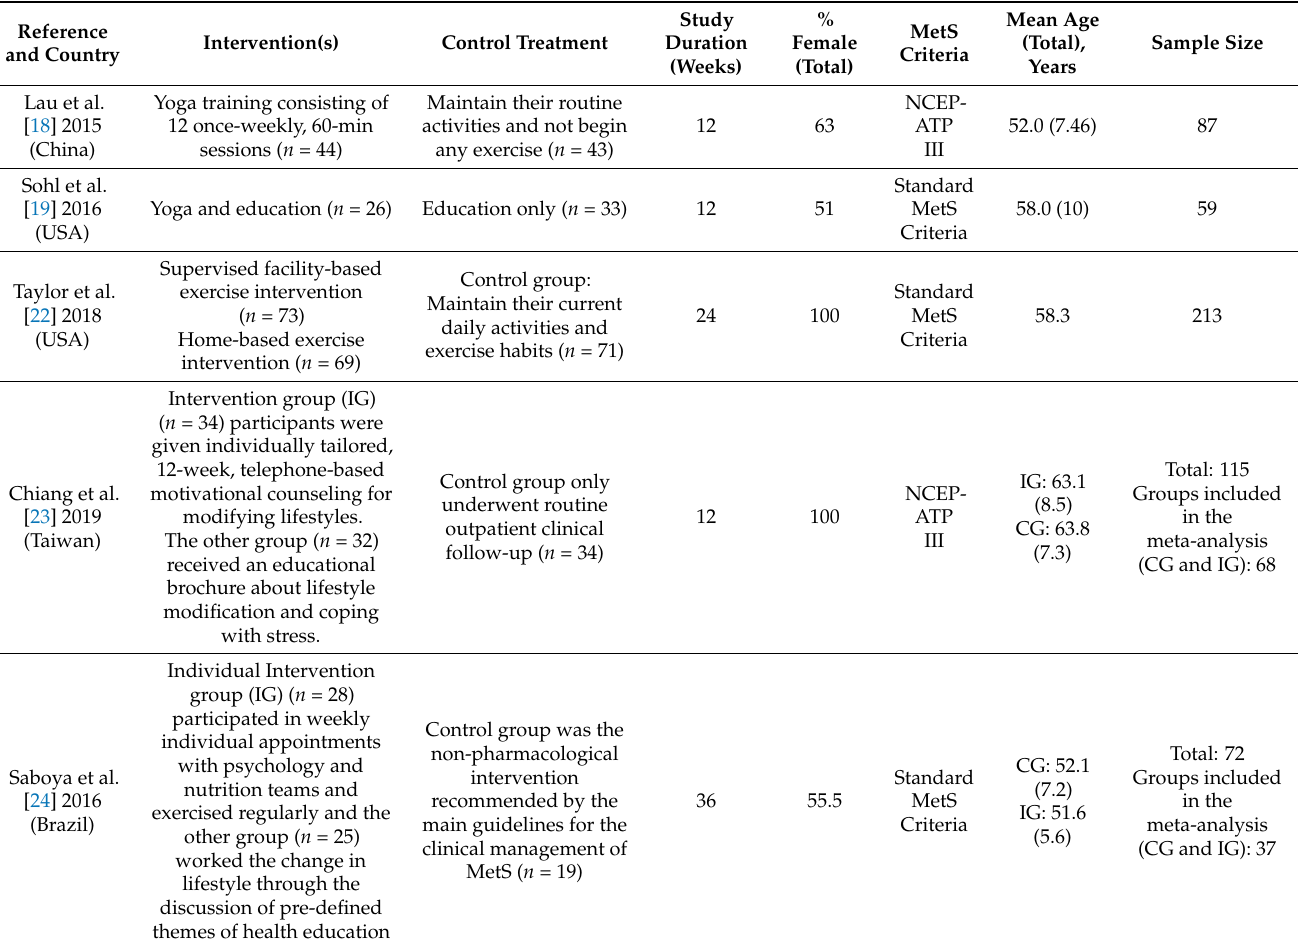
Table 2. Summary of 7 randomized controlled trials included in